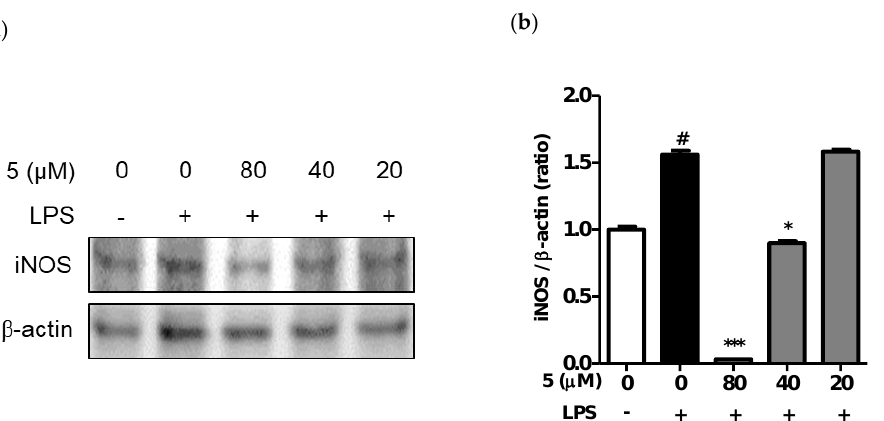
Figure 6. Effect of 3-(3-hydroxyphenyl)-indolin-2-one on iNOS protein expression in lipopolysaccha- ride (LPS)-stimulated RAW264.7 cells; (-): non-treated group, (+): LPS-treated group. ( a ) RAW264.7 macrophages (2.0 × 10 6 cells/6-cm dish) were treated with the indicated concentrations of 3-(3- hydroxyphenyl)-indolin-2-one (20, 40, and 80 µ M) for 2 h and then stimulated with LPS (500 ng/mL) for 12 h. The control group was treated with dimethyl sulfoxide at 0.05%. iNOS protein level was measured by immunoblotting with the specific iNOS antibody. ( b ) Bar chart of the intensity of immunoblot bands visualized using Image J software. Data are presented as the mean ± standard deviation (SD) of three independent experiments. White bar: non-treated group, black bar: LPS treated group, gray bar: sample treated group. # p < 0.0001 vs. the control group. *** p < 0.0001 or * p < 0.05 vs. the LPS group.